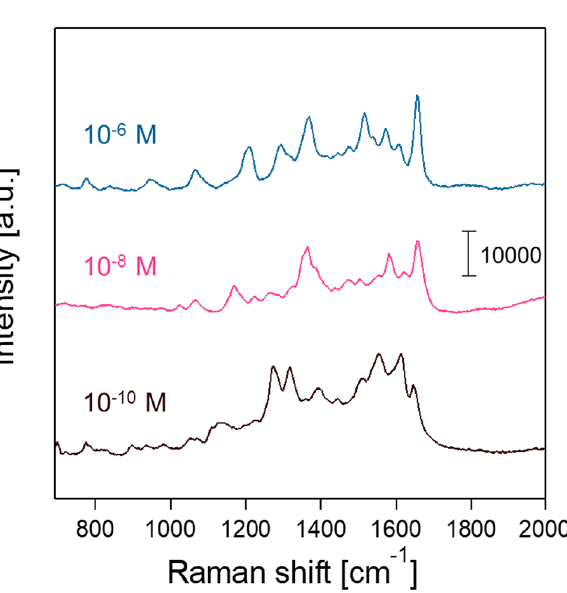
Figure 6. SERS spectra of the 86 nm AgNP aggregates with ( a ) 10 −6 M, ( b ) 10 −8 M, and ( c ) 10 −10 M RhB in the premixed atomization